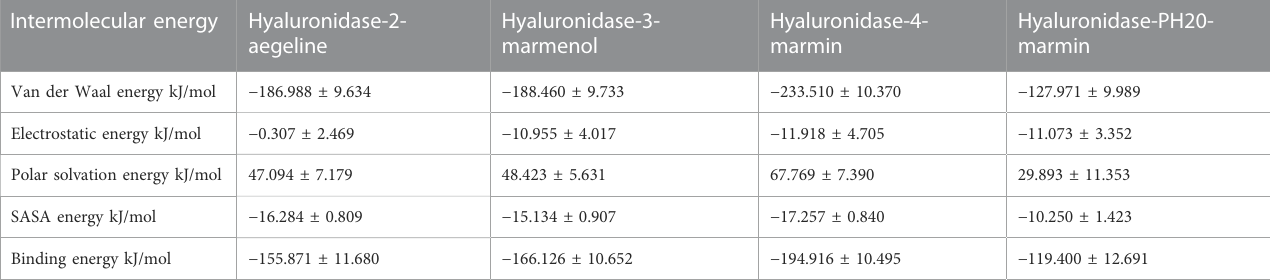
TABLE 7 Results of free energy calculation using MM-PBSA calculation of Hyaluronidase-phytocompounds complexes. Intermolecular